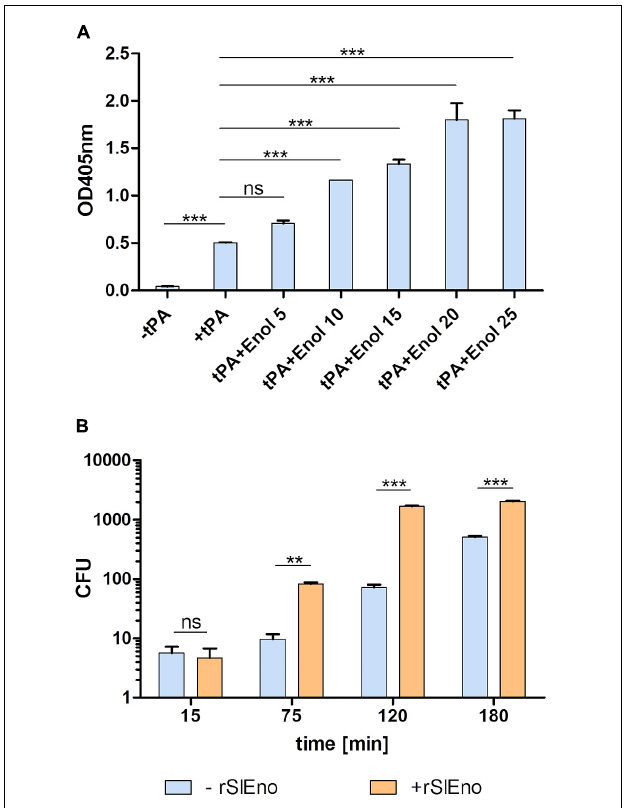
FIGURE 9 | rSlEno triggered the fibrinolytic activity of tissue plasminogen activator (tPA) and enhanced transmigration of S. lugdunensis through a fibrin matrix membrane. (A) The fibrinolytic activity of rSlEno was determined by an addition of 8 µ M tPA and increasing concentrations of rSlEno to microtiter plates containing a fibrin gel. The data were recorded as the reduction in the turbidity of the clot as a quantitative parameter of fibrinolytic activity. Results are presented as fibrinolysis values relative to tPA only without addition of enolase. (B) Transmigration of S. lugdunensis was determined in Transwell cell culture inserts containing a fibrin matrix. Plg-pretreated bacteria with and without additional rSlEno were applied to the fibrin matrix. After 15, 75, 120, and 180 min, the bacteria that migrated from the upper to the lower chamber were plated on blood agar, and after 24 h of growth at 37 ◦ C, the colony-forming units (CFU) were calculated. Results are shown as the mean of three independent experiments with the standard deviation (SD). Statistical analyses were performed using one-way ANOVA (A) or two-way ANOVA (B) with Bonferroni multiple comparisons post-test (** p < 0.01, *** p < 0.001, ns, not significant).